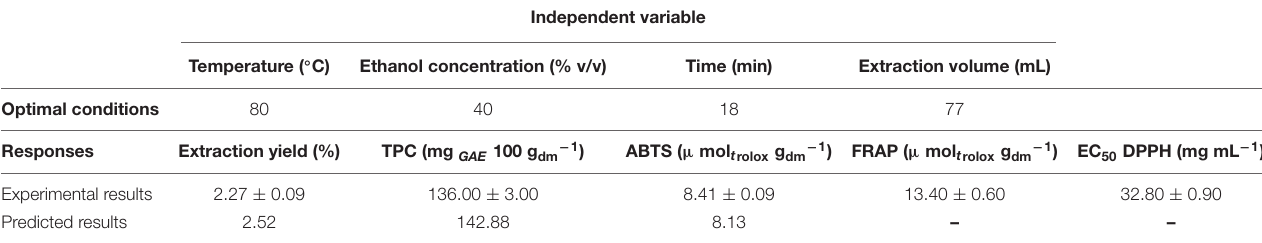
TABLE 5 | Optimal conditions for the extraction of active compounds in DP and response variables evaluated ( n = 3, mean ±